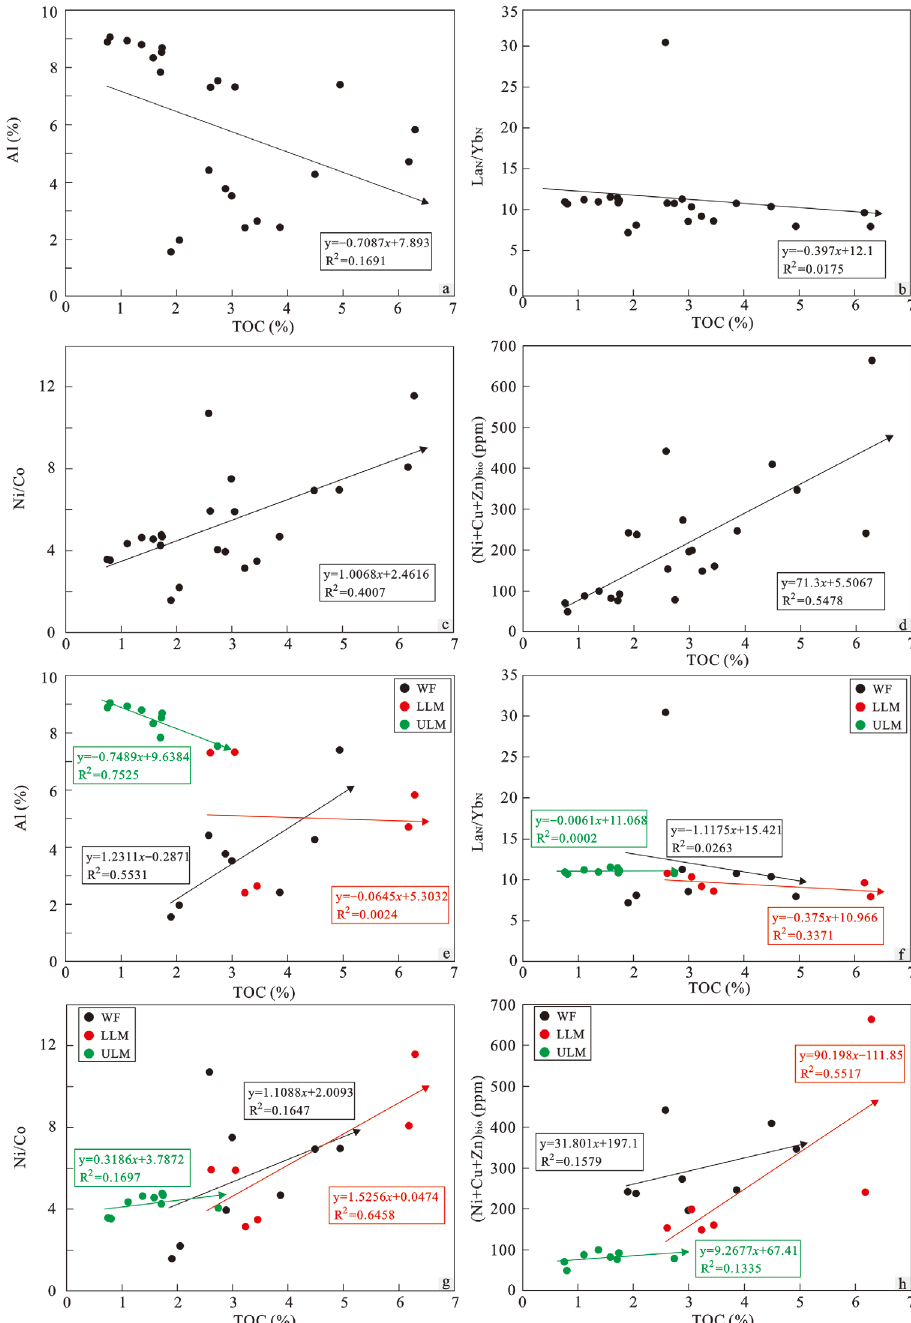
Figure 13. Correlations between TOC content and the factors that influence OMA. ( a )~( d ) Crossplots of TOC vs. terrigenous influx proxy Al, deposition rates proxy La N /Yb N , palaeoredox proxy Ni/Co, and palaeoproductivity proxy (Ni + Cu + Zn) bio of the Wufeng – Longmaxi Formation, respectively. ( e ) ~( h ) Crossplots of TOC vs. Al, La N /Yb N , Ni/Co, and (Ni + Cu + Zn) bio of the WF, LLM, and ULM, respectively. Overall, OMA is controlled by both redox conditions and productivity. However, the factors that influence OMA change vertically, and OMA is mainly influenced by terrigenous influx in the WF and ULM and controlled by redox conditions and productivity in the LLM.